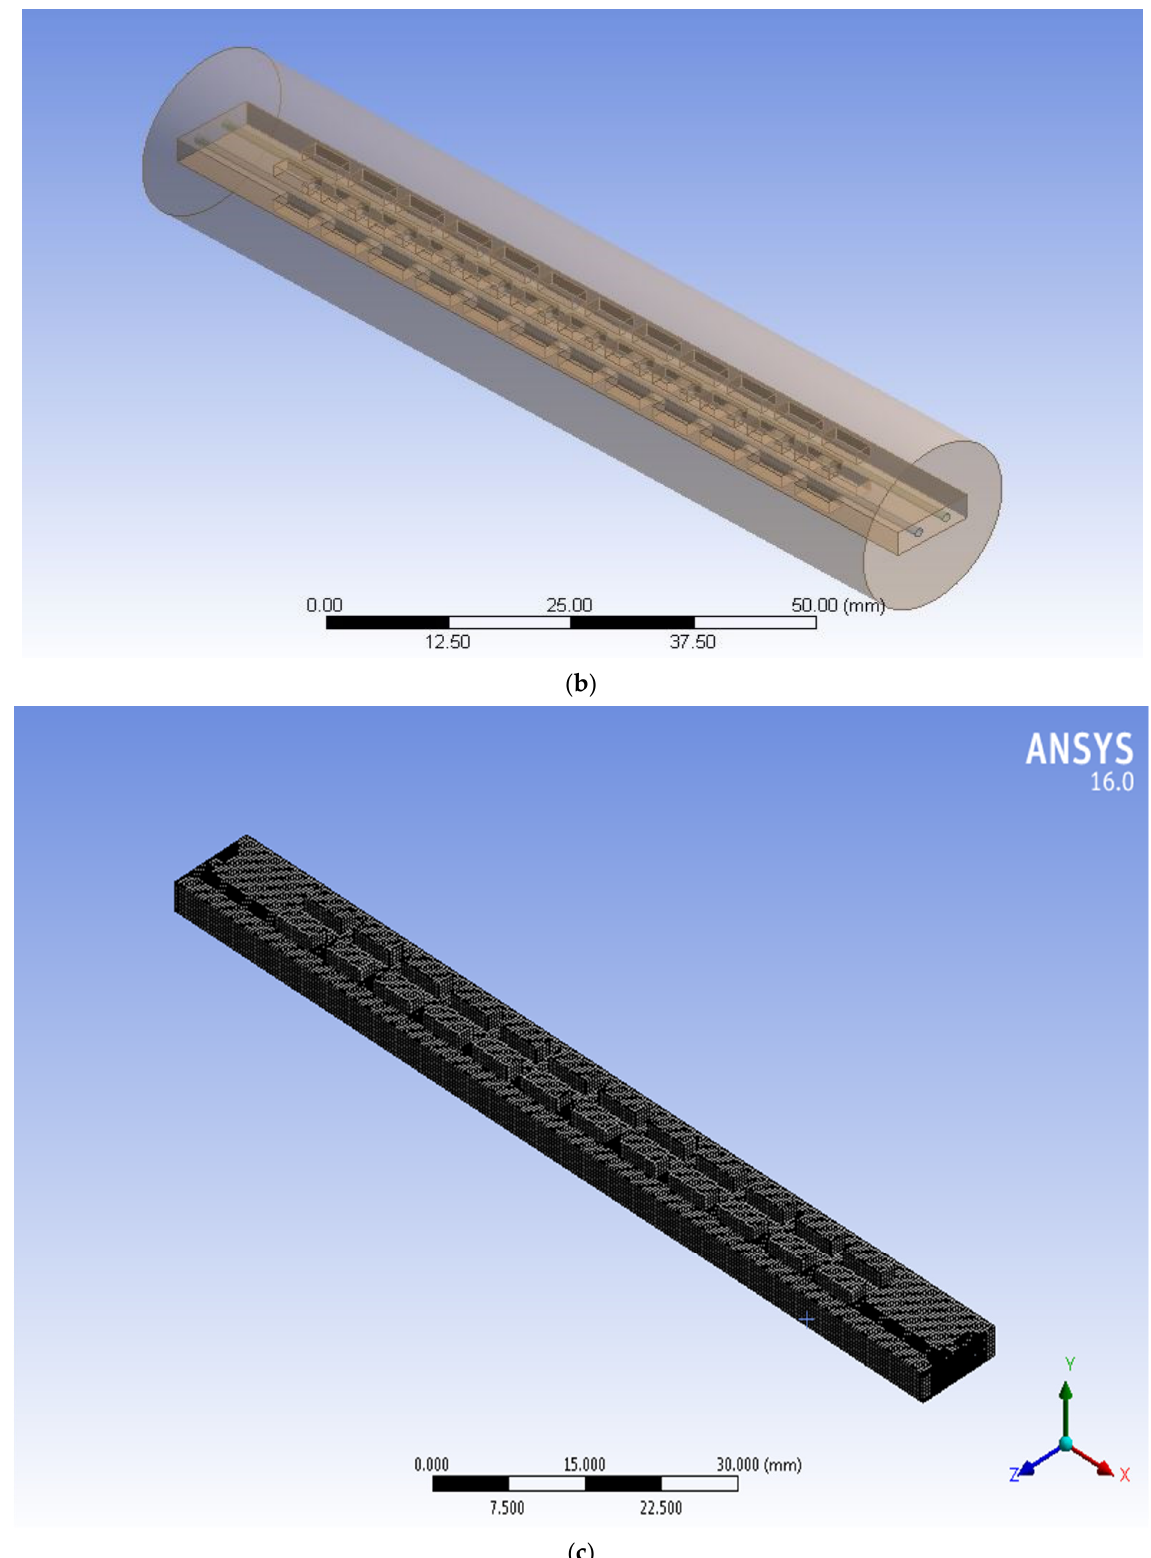
Figure 3. ( a , c ) Computational grids ( b ) Computational domain, used for computational fluid dynamics (CFD) simulation.